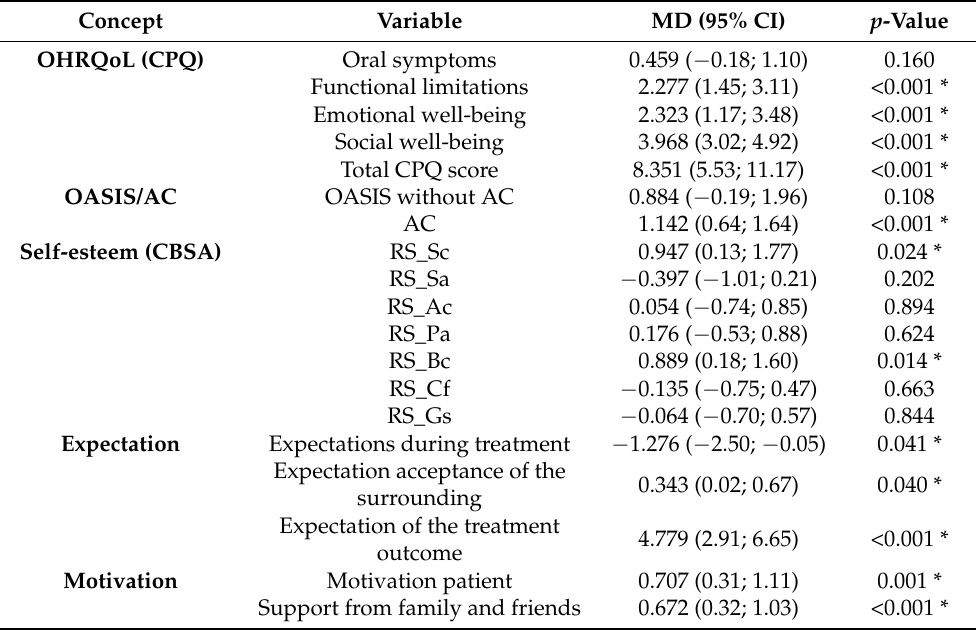
Table 3. Cleft versus control group.